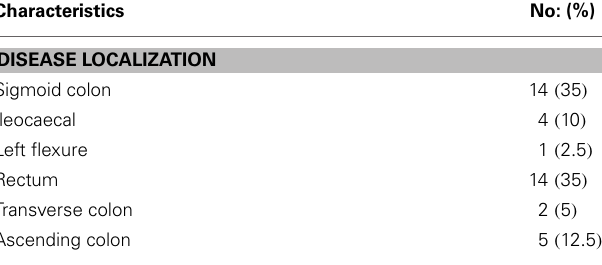
Table 1 | Patient demographics, pathology, and biochemical